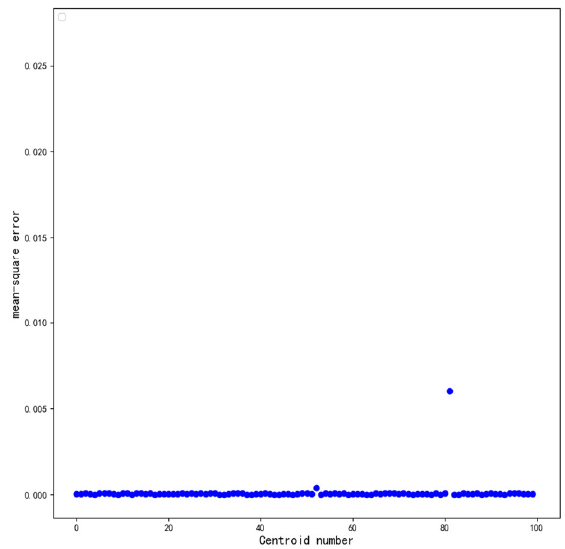
Figure 14. Mean square error of 100 centroids randomly selected; the blue points in the figure are the root mean square error of the predicted